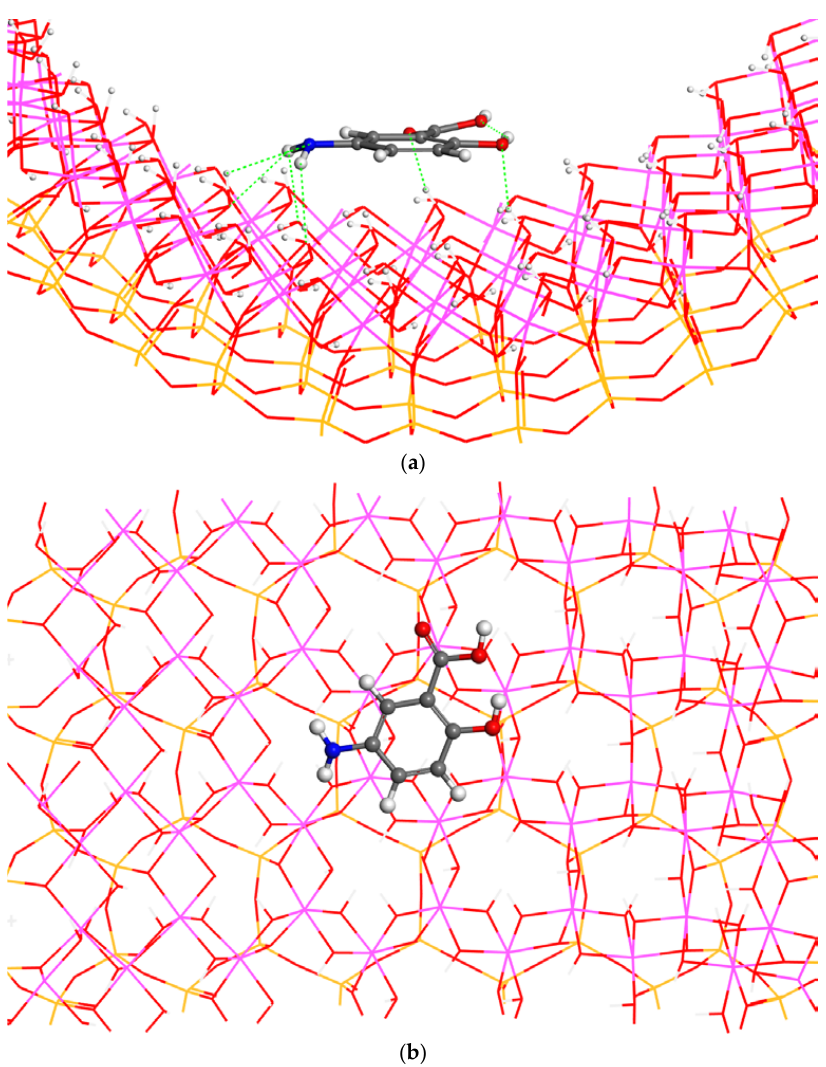
Figure 3. Adsorption of the conformer F1 of 5-ASA placed parallel to the surface in a crossed configuration in the halloysite after its optimization. Views from the (001) ( a ) and (010) ( b ) crystallographic